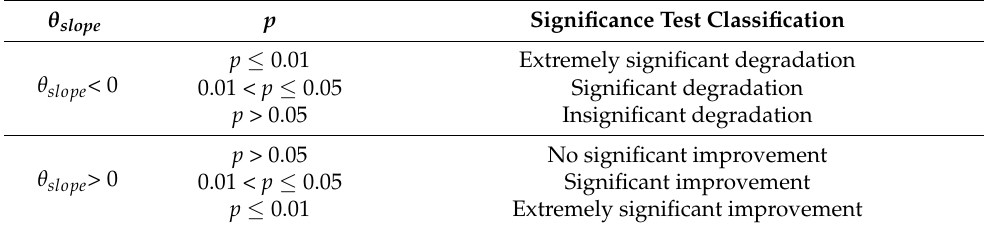
Table 2. Significance classification